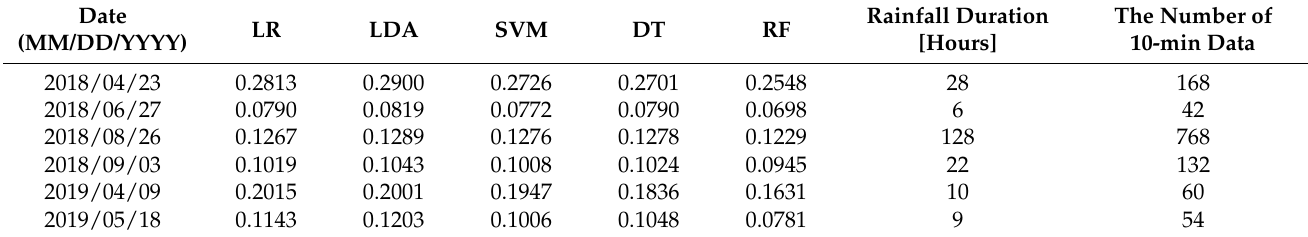
Figure 11. Estimated precipitation areas of LDA and RF for two types (stratiform and a convective) of cases. Estimated dry (blue), estimated wet (red), observed dry (triangle), and observed wet (circle). Table 5. MSPE of the five models for the validation data sets. Each data is divided into the training set (80%) and the test set (20%).